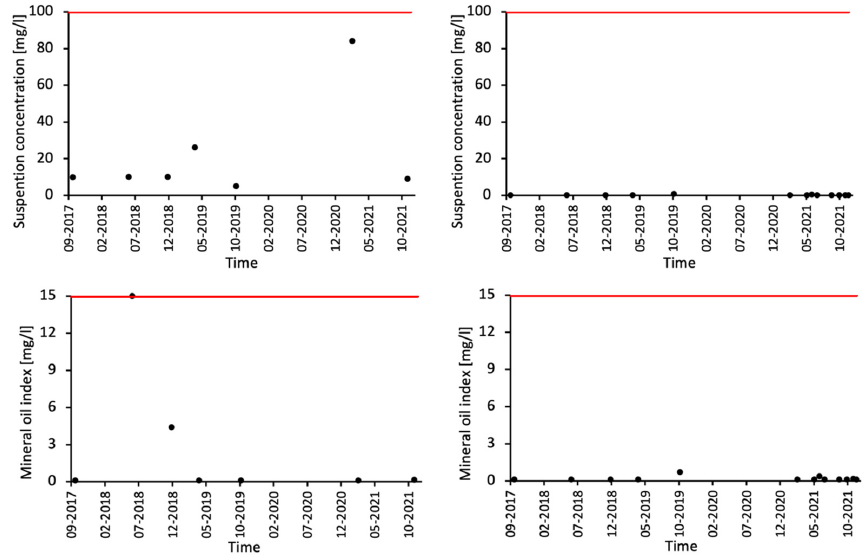
Figure 7. Characteristics of precipitation wastewater from the ZUOK site in Olsztyn between October 2017–October 2021. The red line indicates the permissible values as set out in the integrated permit.